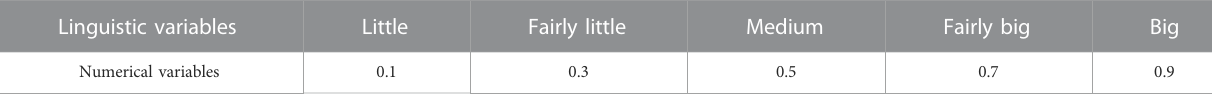
TABLE 2 Conversion between linguistic variables and numerical variables. Linguistic